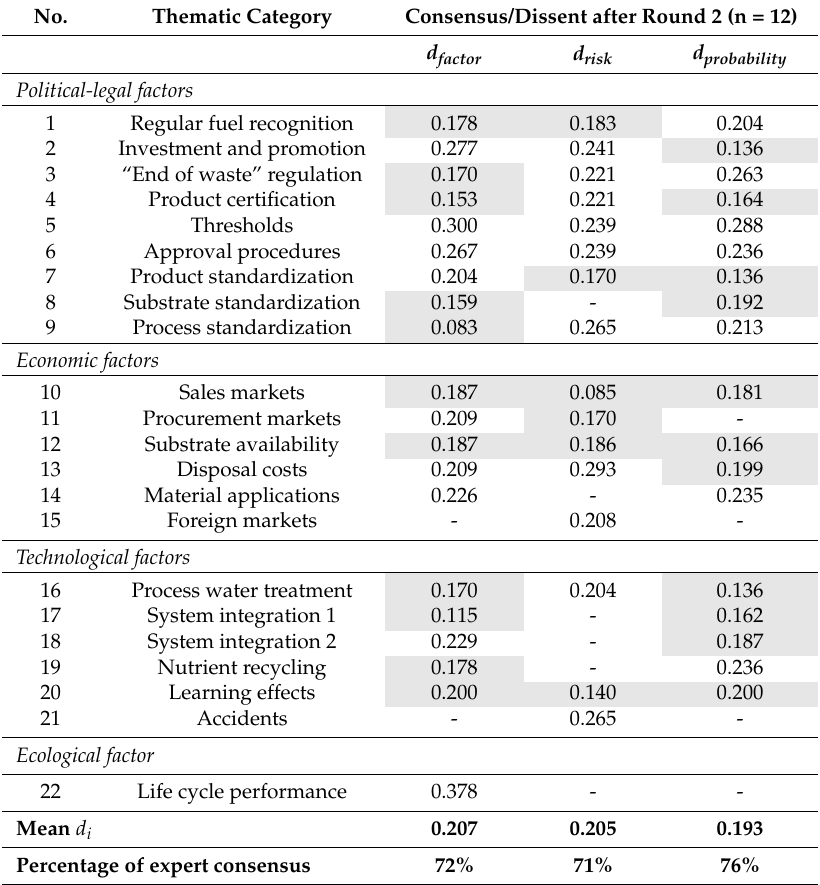
Table 2. Results on the fuzzy evaluation regarding expert consensus/dissent after round